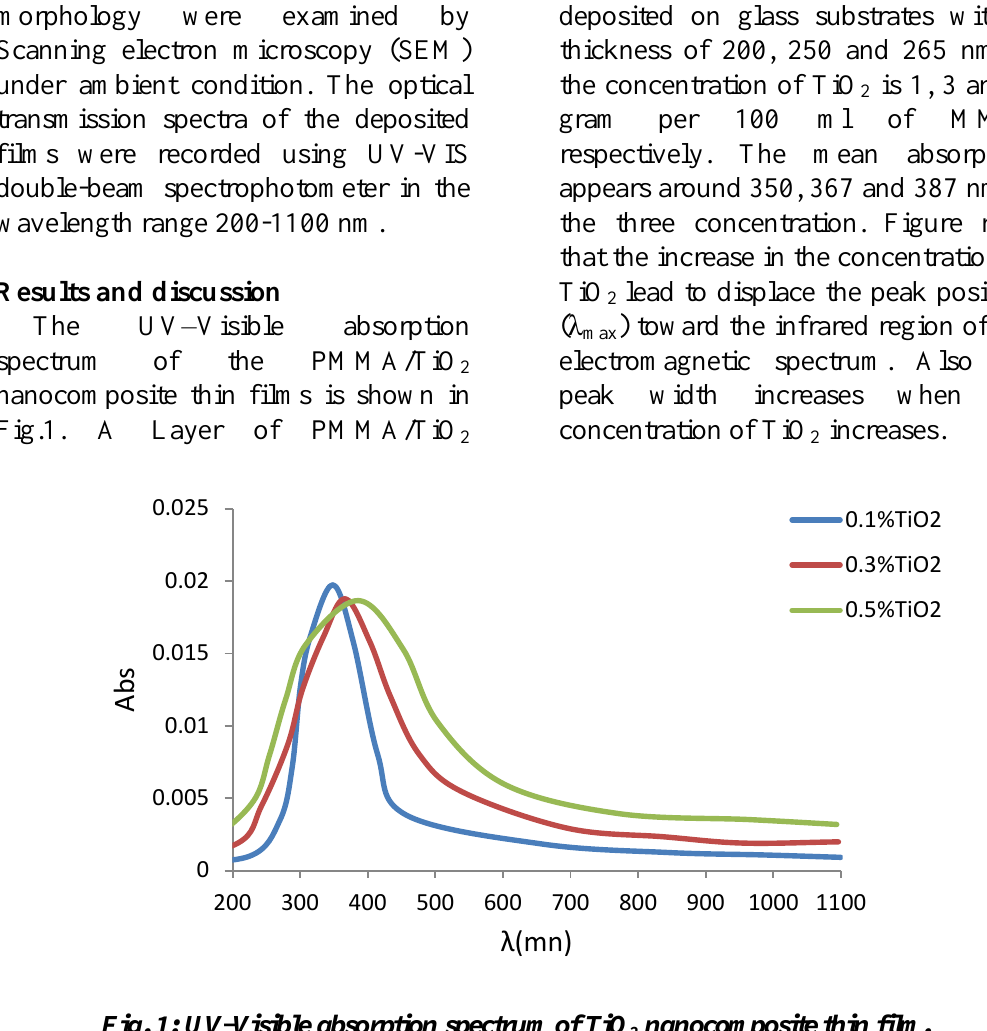
Fig. 1: UV-Visible absorption spectrum of TiO